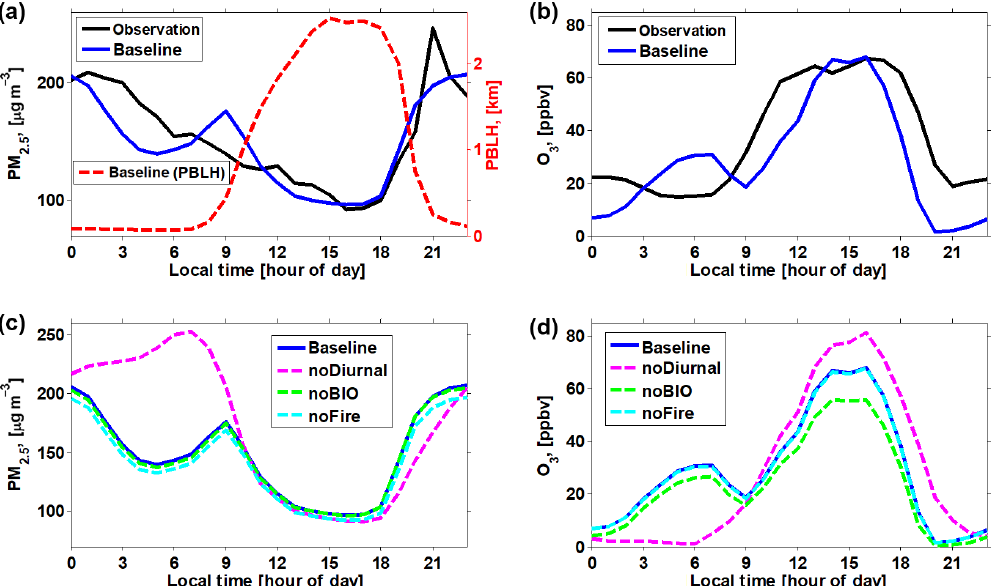
Figure 4. Average diurnal patterns of pollutants during the 2–15 May 2015 simulation period. (a) Modelled and observed PM 2 . 5 and model PBL height (PBLH), (b) O 3 , (c) results of sensitivity studies for PM 2 . 5 , and (d) results of sensitivity studies for O 3 . (a) and (c) are for site CVR, and (b) and (d) are for site AIR (marked in Fig. 2). The sensitivity runs “noFire” and “noBIO” show model results without biomass burning and biogenic emissions, respectively, and “noDiurnal” shows model results with constant anthropogenic emissions rates throughout the